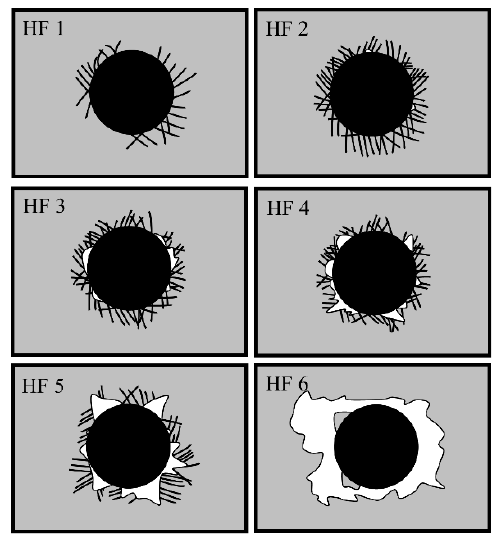
Figure 8. VDI-3198 standard for indentation morphology.